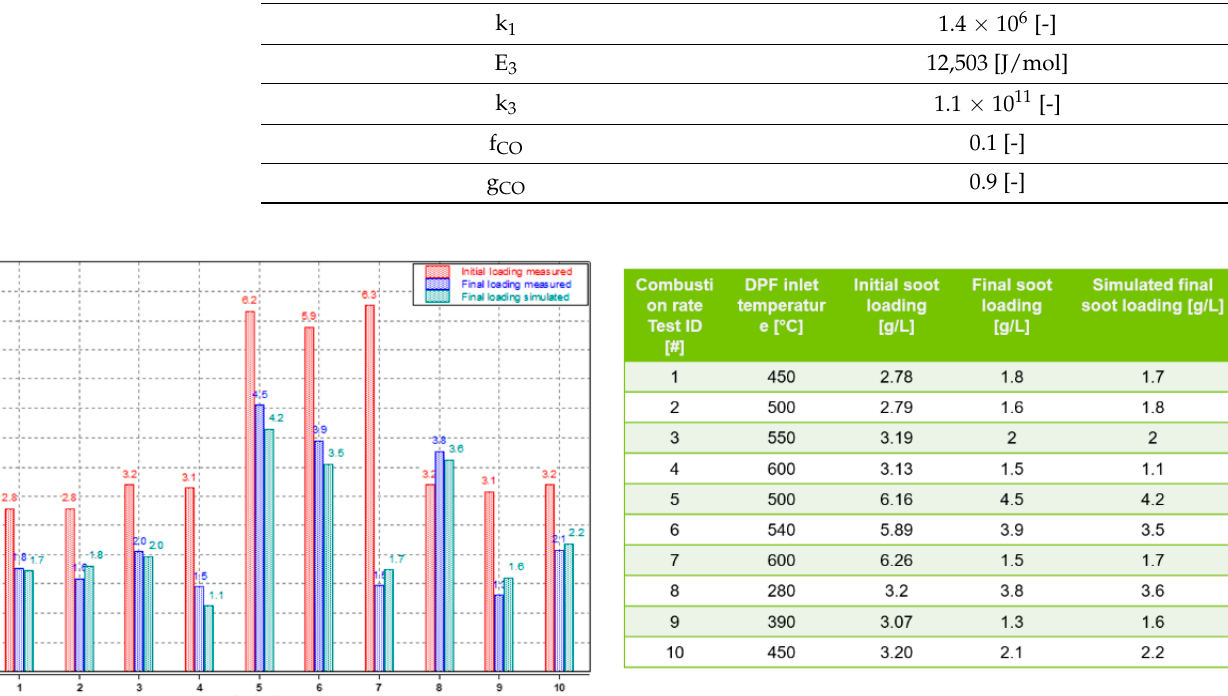
Table 11. Optimized values of the DPF tuning parameters.